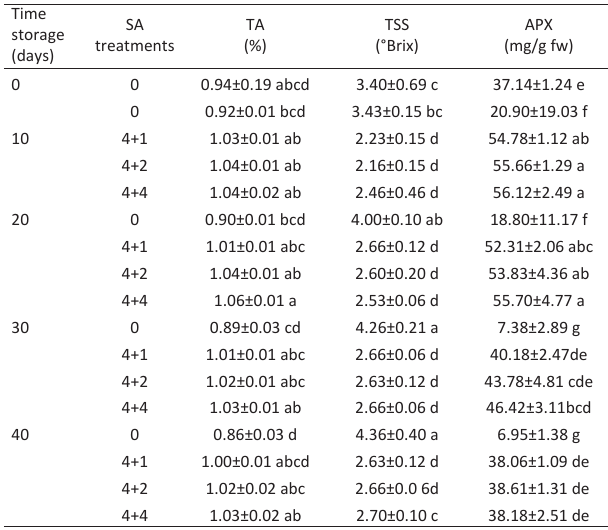
Table 3 - Effect of pre and postharvest treatments SA in TA, TSS, APX of tomato fruit cv. Baraka and stored at 10°C